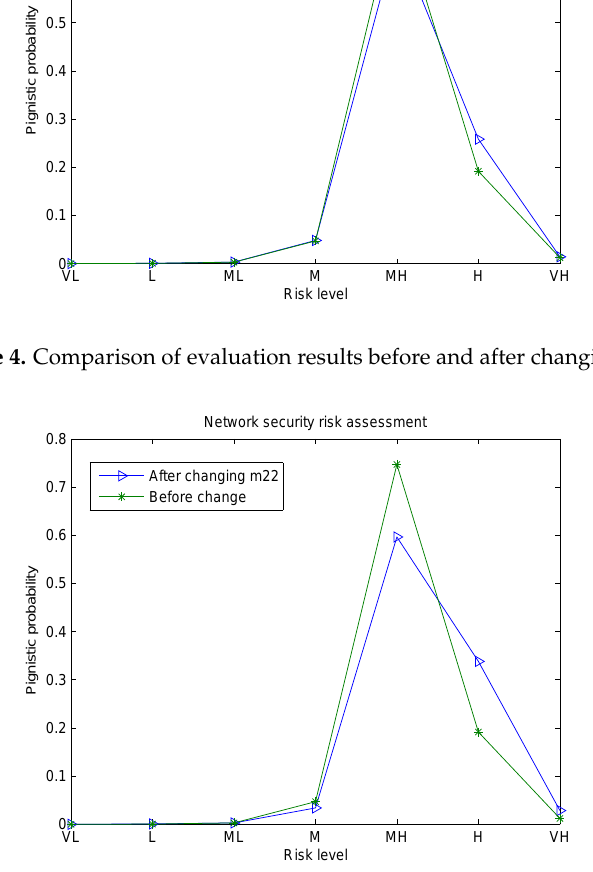
Figure 5. Comparison of evaluation results before and after changing evidence m 22